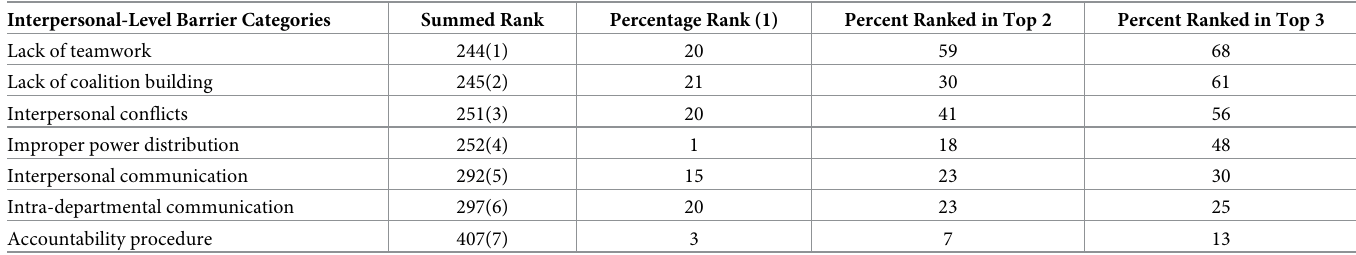
Table 4. Rank orders (interpersonal barriers).